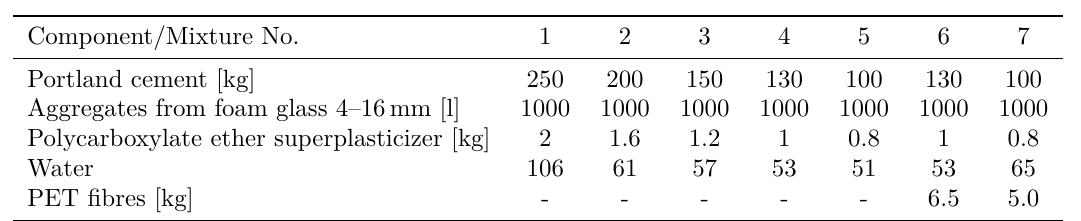
Table 1. Mixtures of lightweight concrete.